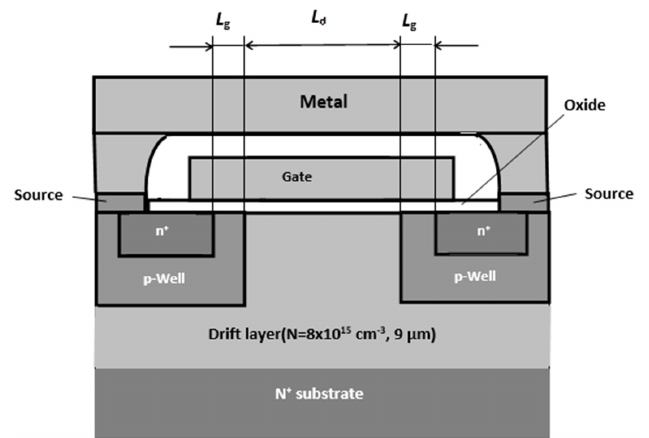
Figure 7. Cross-section of an elementary cell of a 4H-SiC MOSFET. The gate length Lg is 0.5 μ m, the oxide thickness d is 60 nm, and the drift (blocking) layer thickness Hd is 9 μ m [37].